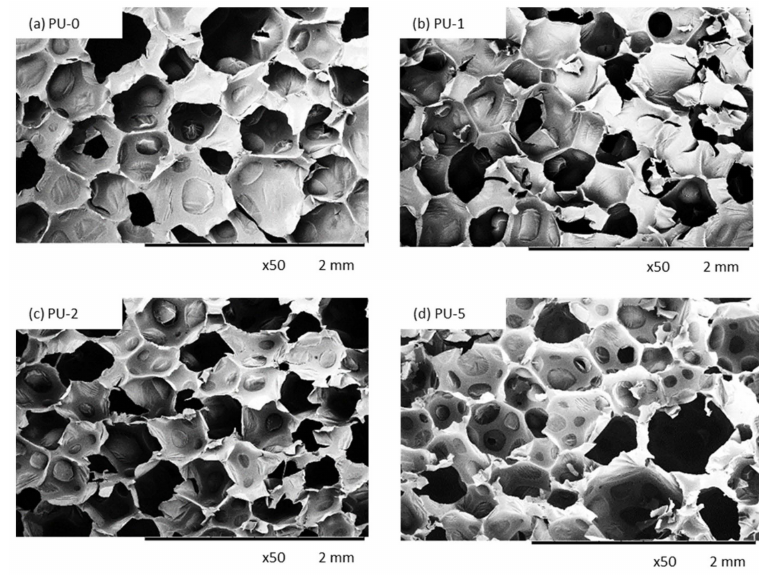
Figure 6. The cellular structure of ( a ) PU-0, ( b ) PU-1, ( c ) PU-2, and ( d ) PU-5 observed at a magnification of 50 ×